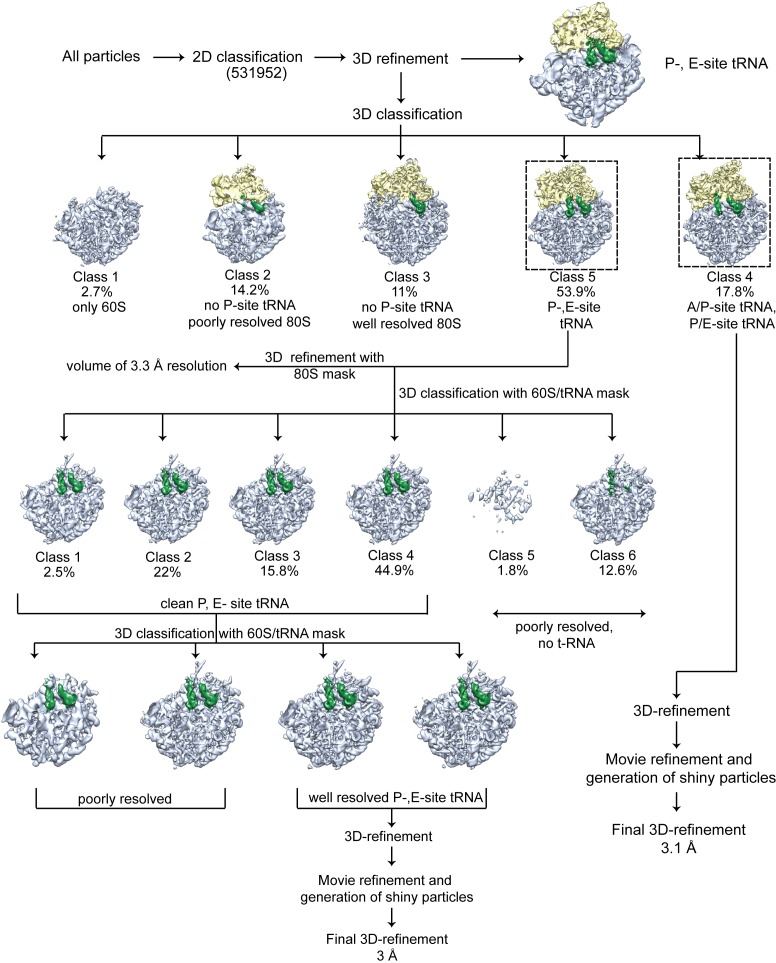
Cryo-EM data processing of the XBP1u nascent chain stalled ribosomes.In silico sorting procedure of the data is shown in the schema. Intermediate densities are shown with 60S in blue, 40S in yellow and tRNAs in green. For details check experimental methods section for data processing.